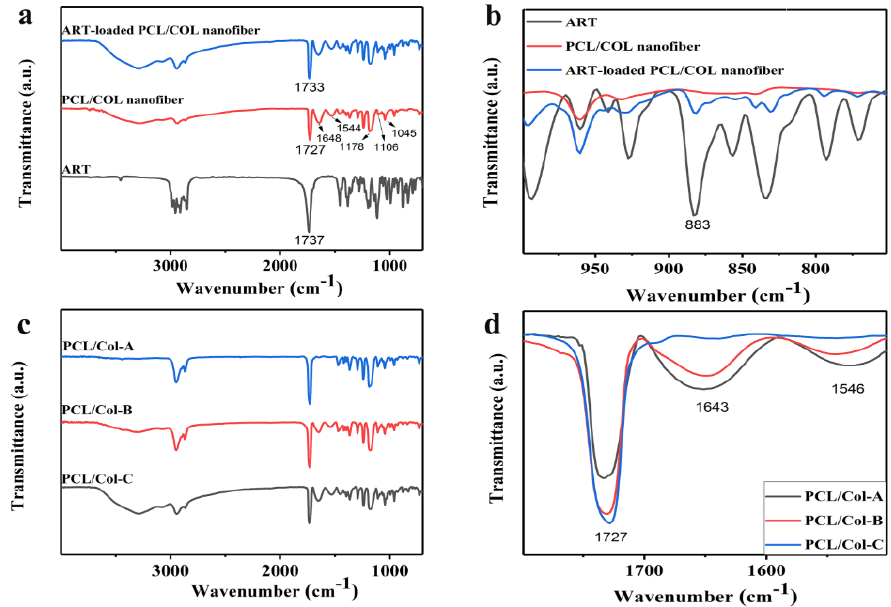
Figure 3. FTIR spectra of ( a , b ) pure ART, PCL/Col nanofibers, ART-loaded PCL/Col nanofibers; ( c , d ) ART-loaded nanofibers with different polymer ratios: PCL/Col-A, PCL/Col-B, and PCL/Col-C.